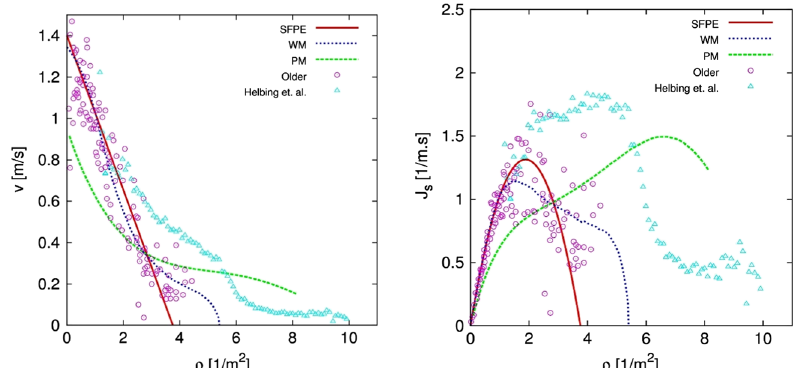
Fig. 3 Fundamental diagrams for pedestrian movement in planar facilities [Lines represent specifications given by planning handbooks (SFPE: Handbook, PM: Predtechenskii and Milinskii, WM: Weidmann). Points represent observations of experiments] (Seyfried et al. [26])